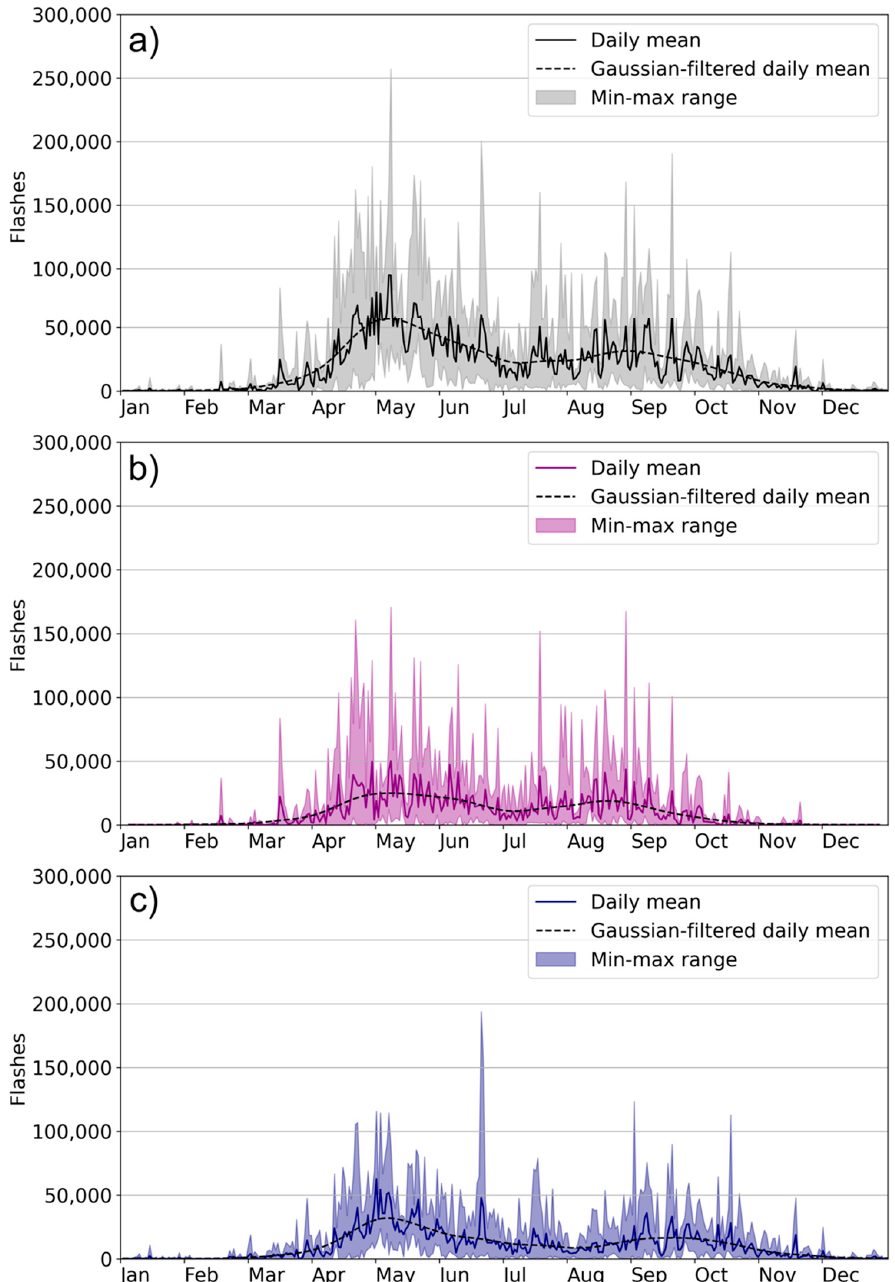
Figure 4. Daily means (solid lines), Gaussian-filtered daily means (dashed lines) and min–max range (shaded colors) of lightning flashes in ( a ) the whole of Vietnam, ( b ) North Vietnam, and ( c ) South Vietnam in 2015–2019.